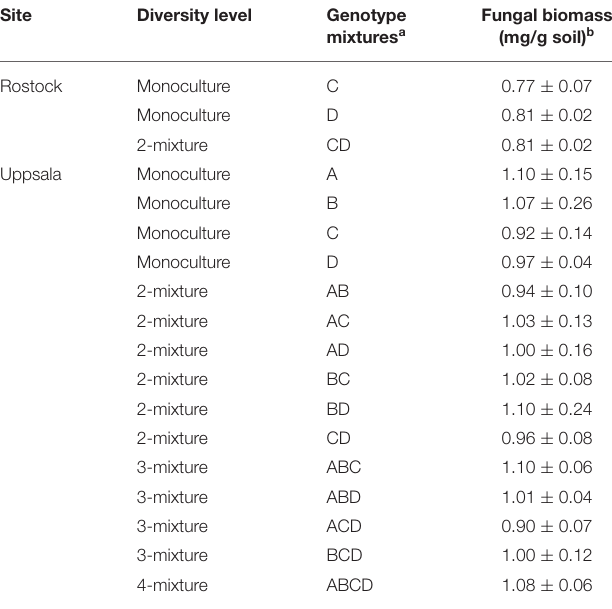
TABLE 1 | Fungal biomass (mean ± SD) per genotype treatment in 2017 for Rostock and Uppsala.